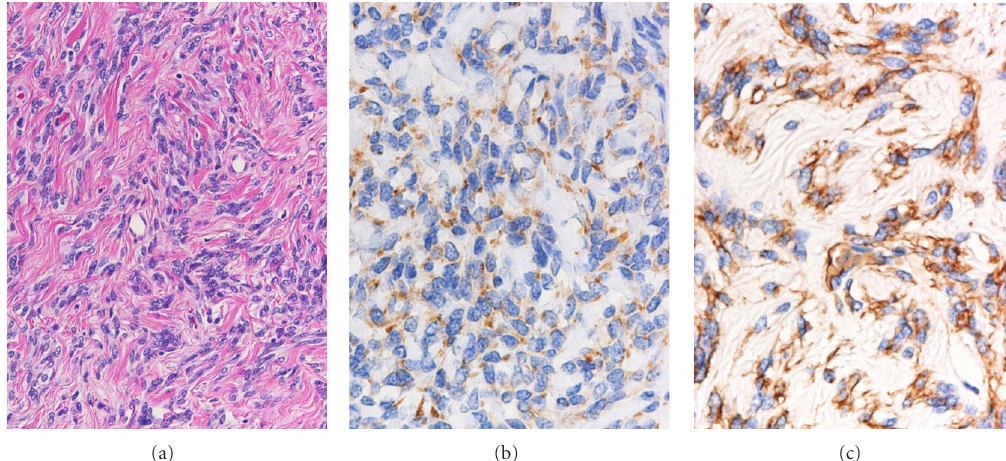
Figure 4: Histopathological features of the tumor. (a) the spindle cells are arranged in a patternless fashion in the collagenous matrix on hematoxylin-eosin staining ( × 200). (b) the vast majority of the tumor cells were stained di ff usely and strongly for CD34 ( × 400). (c) cytoplasm in the numerous tumor cells expressed the Bcl-2 ( ×